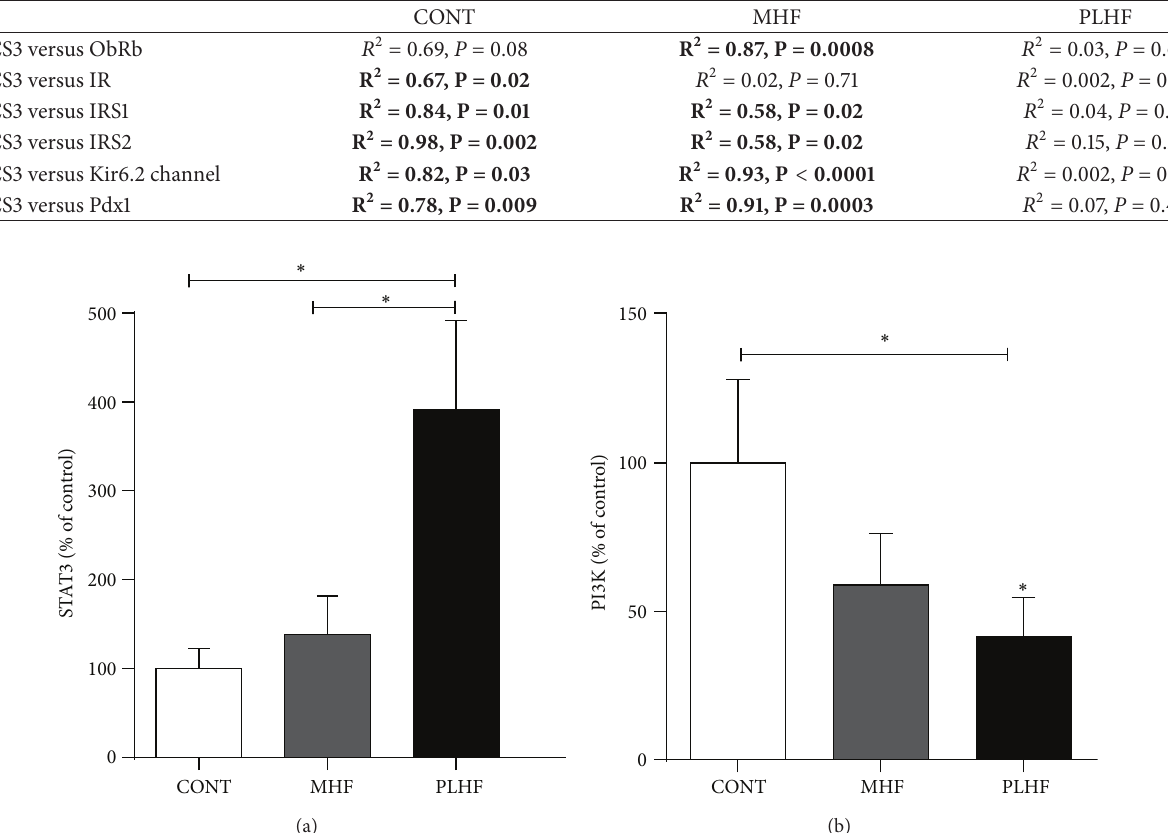
Figure 4: Pancreatic STAT3 (a) and PI3K mRNA expression (b). Data are means ± SEM, 𝑛 = 10–18 per group. STAT3: signal transducer and activator of transcription 3; PI3K: phosphatidylinositol 3-kinase. ∗ 𝑃 < 0.05